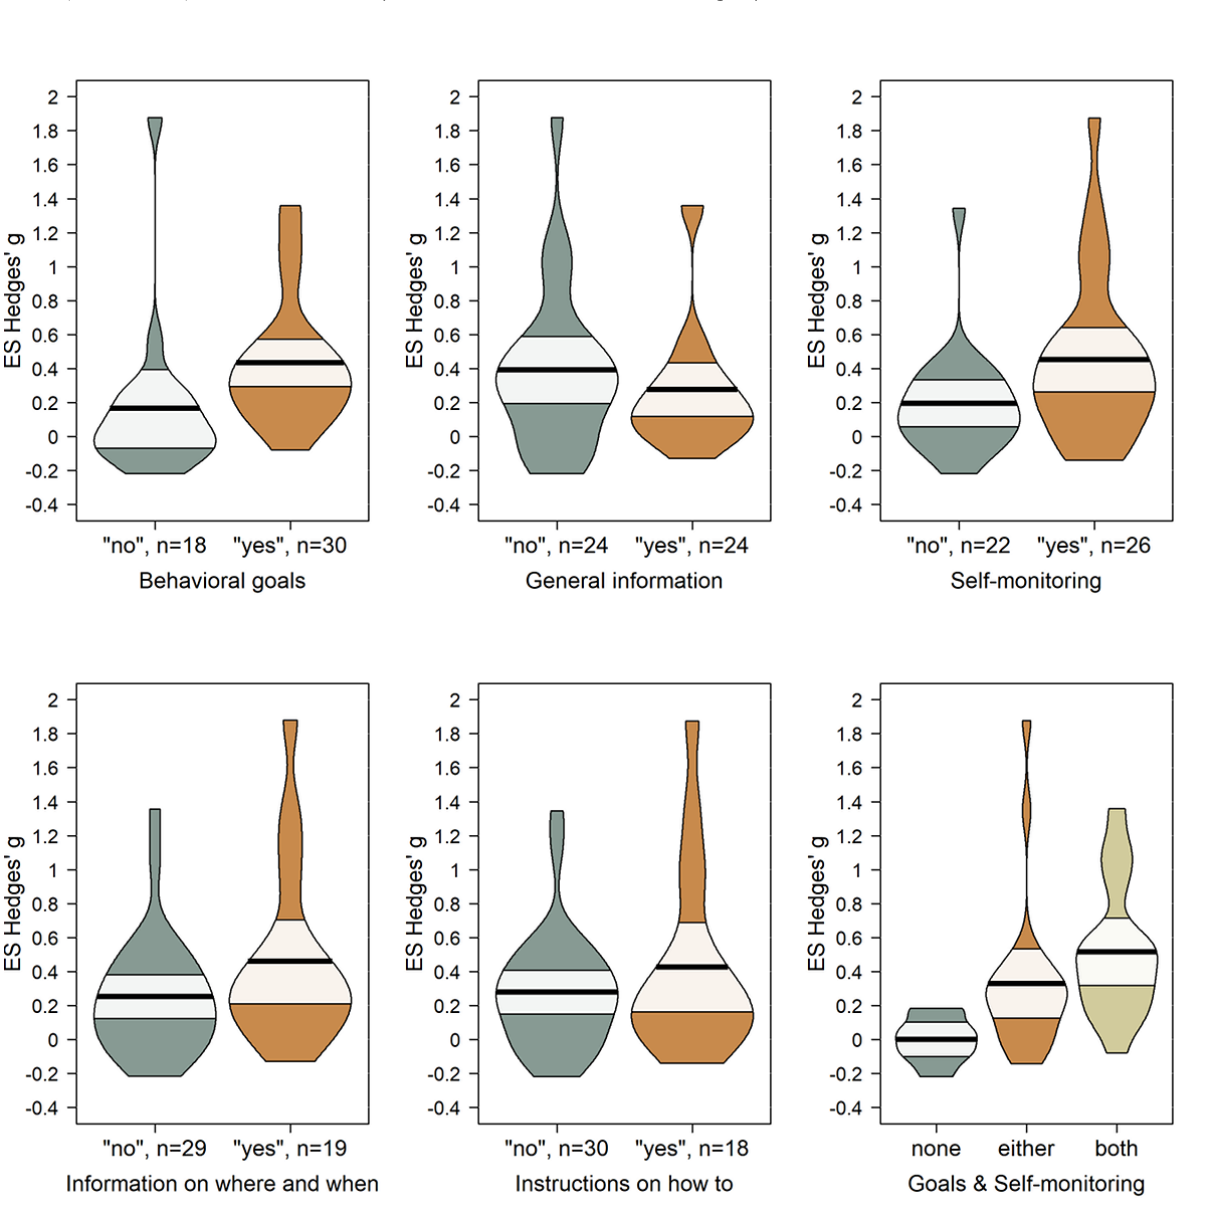
Figure 4. Differences in intervention efficacy depending on the use of the 5 most common behavior change techniques (BCTs). In each panel, “no” means that the BCT was not used and “yes” means that the BCT was used. The “n” next to “yes” and “no” indicates the number of studies in each group. The black line shows the mean intervention efficacy with a 95% CI in white. The curved areas depict density of data points (ie, fine-grained vertical histograms) for all included studies. The last panel shows intervention efficacy depending on a combination of behavioral goals and self-monitoring (n(none)=9, n(either)=22, n(both)=17). These depictions are not controlled for baseline group